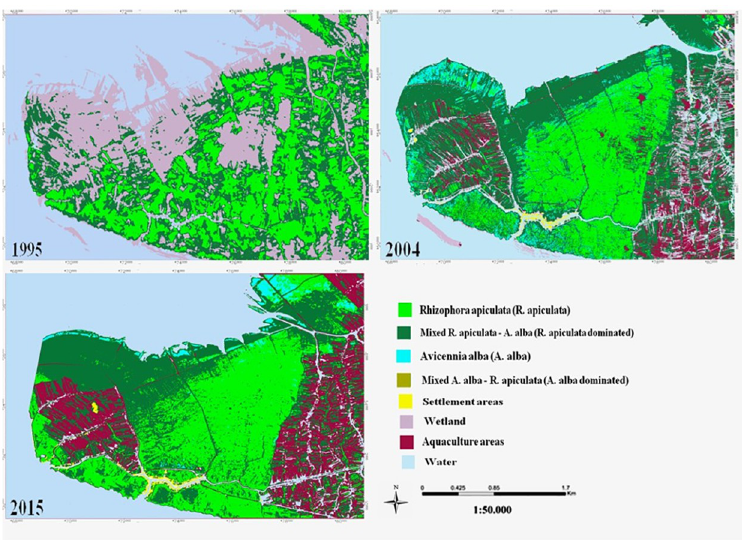
Fig 9. Satellite image classification results (republished satellite data under a CC BY license, with permission from the Department of Remote Sensing, Ministry of Natural Resources and Environment of Vietnam, original copyright [1995, 2004,